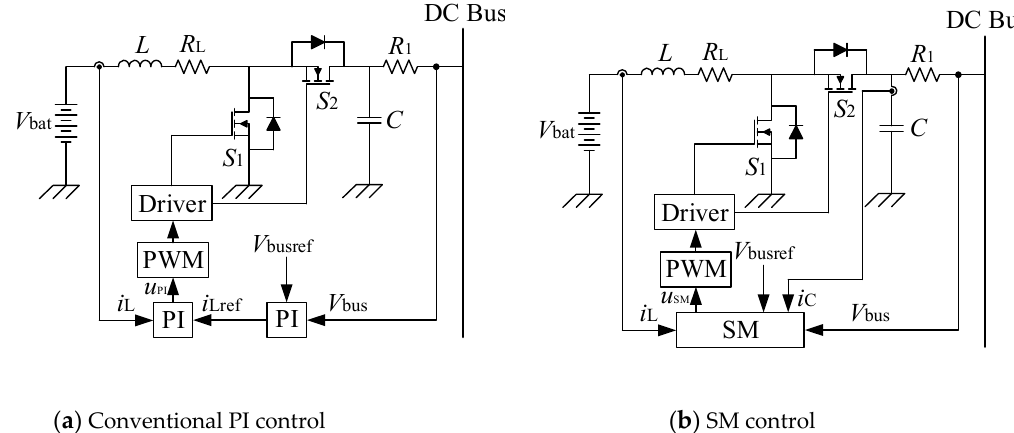
Figure 10. The structure of the investigated five-bus standalone DC microgrid.